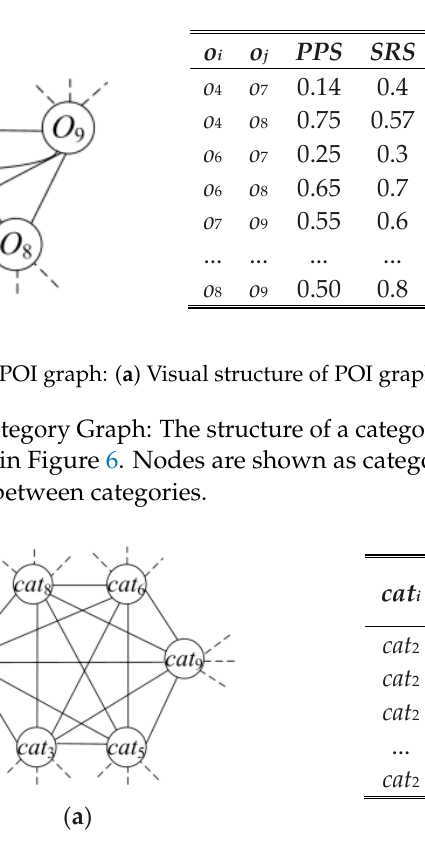
Figure 6. Example of Category Graph: ( a ) Visual structure of category graph; ( b ) Content of category graph.